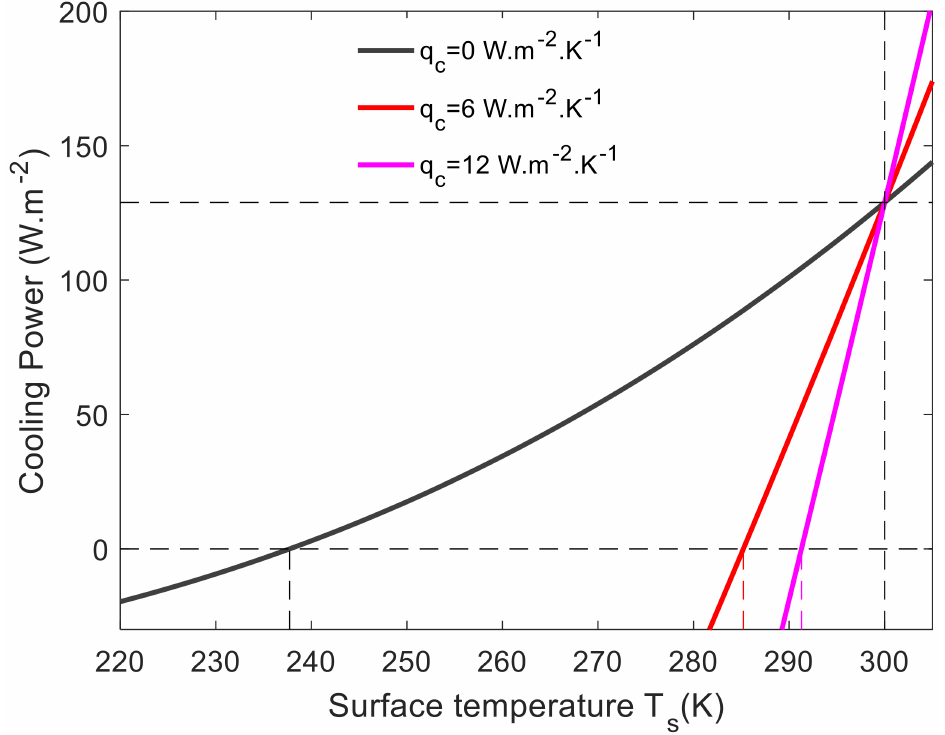
Figure 11. Calculated net nighttime cooling performance of the proposed cooler structure as a function of device temperature with different thermal coefficients q c = 0, q c = 6 and q c = 12 W/m 2 · K 1